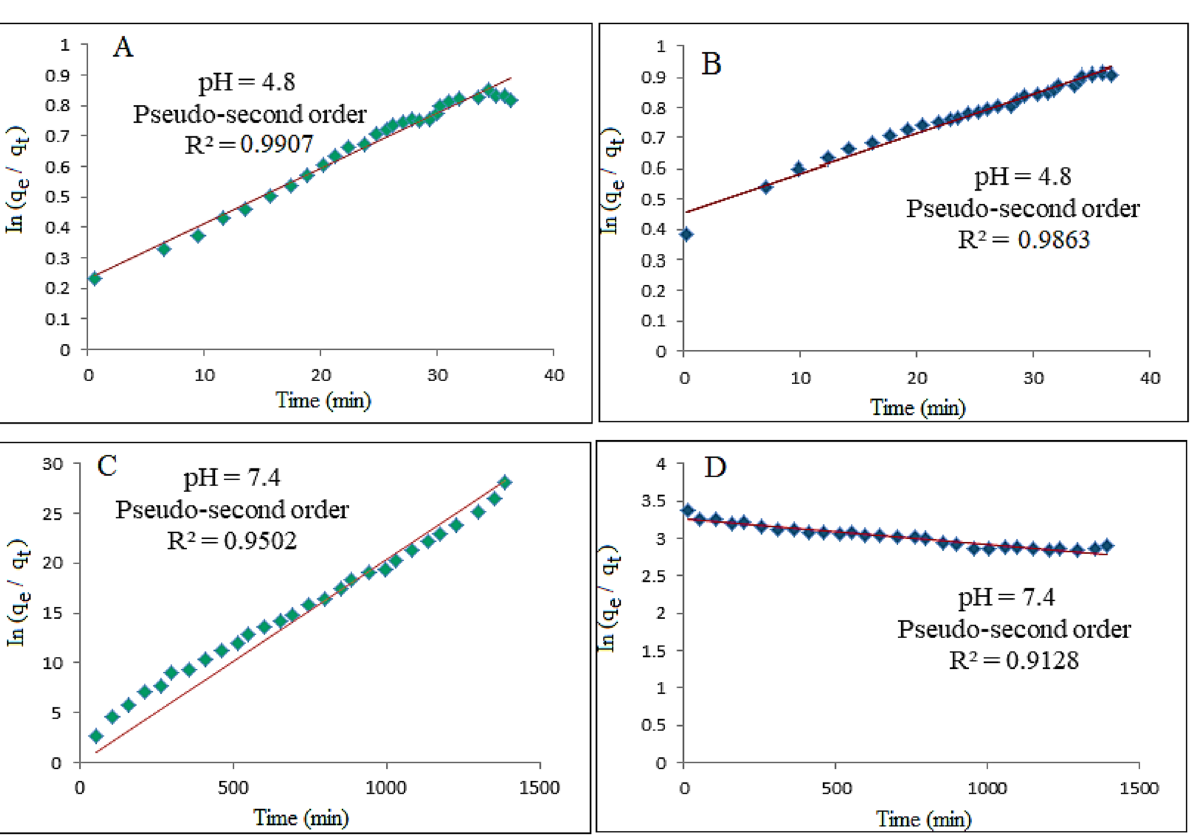
Figure 12. Fitting the data for sorafenib release from ( A ) FPEGSO-MLDH nanoparticles; ( B ) FPVASO-MLDH nanoparticles dissolved in dimethyl sulfoxide into different solutions to the pseudo-second-order kinetics for pH 7.4; ( C ) FPEGSO-MLDH nanoparticles; ( D ) FPVASO-MLDH nanoparticles dissolved in dimethyl sulfoxide into different solutions to the pseudo-second-order kinetics for pH 4.8. Abbreviations: t, time; q t , release at time